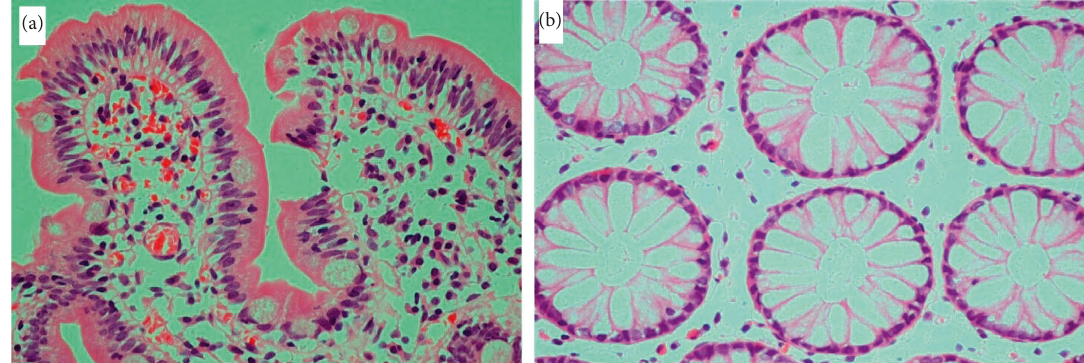
Figure 3: Light microscopic images (H&E staining). (a) Normal duodenal lining (40X). (b) Normal colonic lining